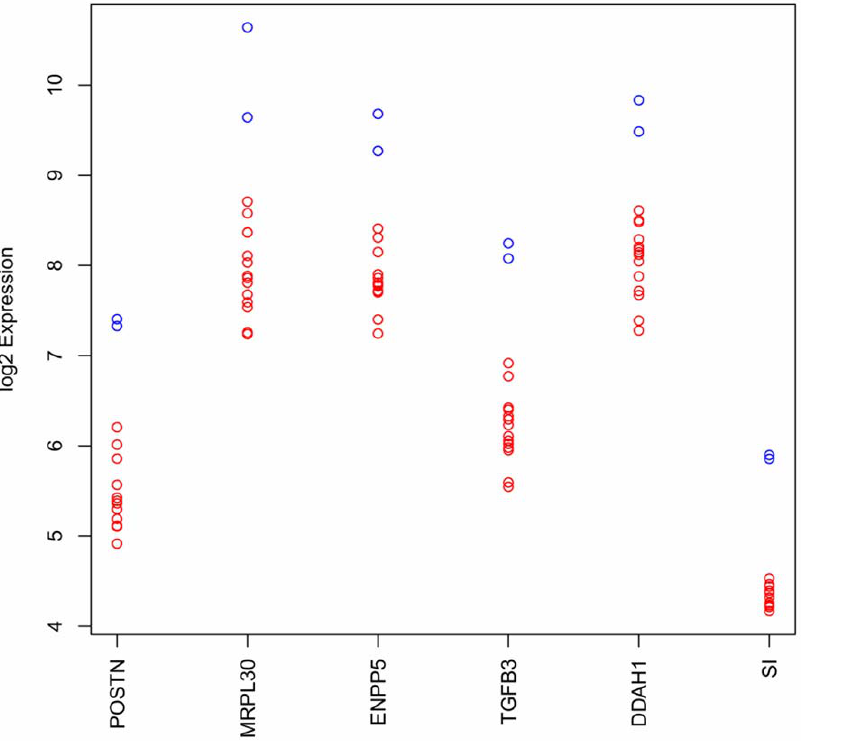
Figure 4. Log2 expression estimates for the six genes identified as downregulated by at least a factor of 2 in all samples relative to mean control value. For each gene, blue circles indicate log2 expression estimates for siCON samples and red circles indicate values for knockdown samples.